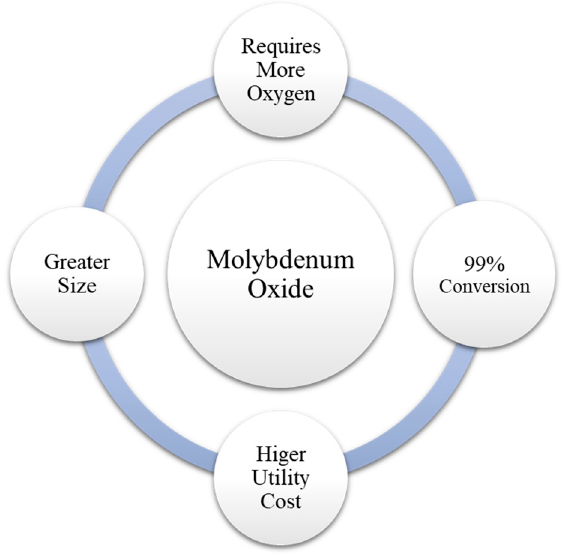
Figure 3. Molybdenum-based process.